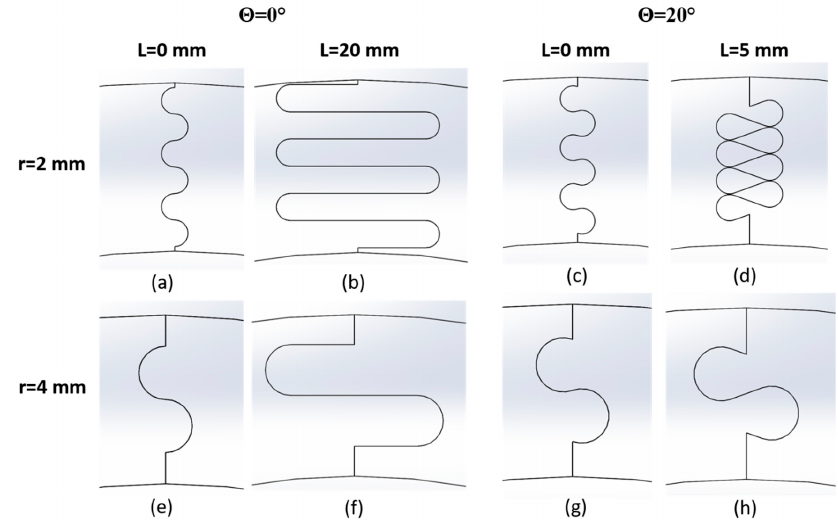
Figure 3. Suture shapes produced as the contact angle ( a , b , e , f vs. c , d , g , h ), tangent length ( a , c , e , g vs. b , d , f , h ), and tab radius ( a – d vs. e – h ) are changed.